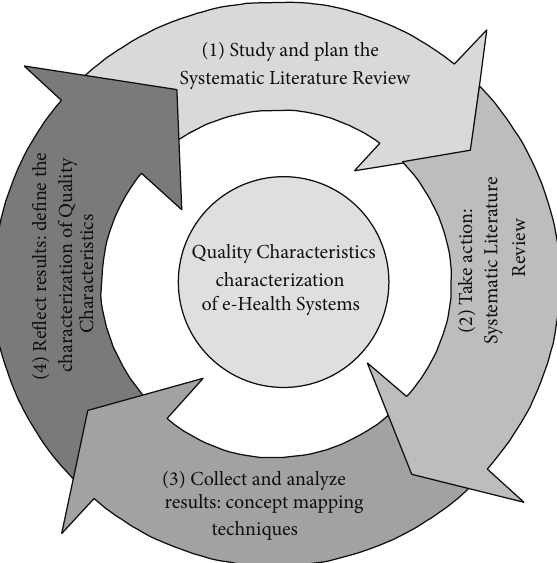
Figure 1: Method to group Quality